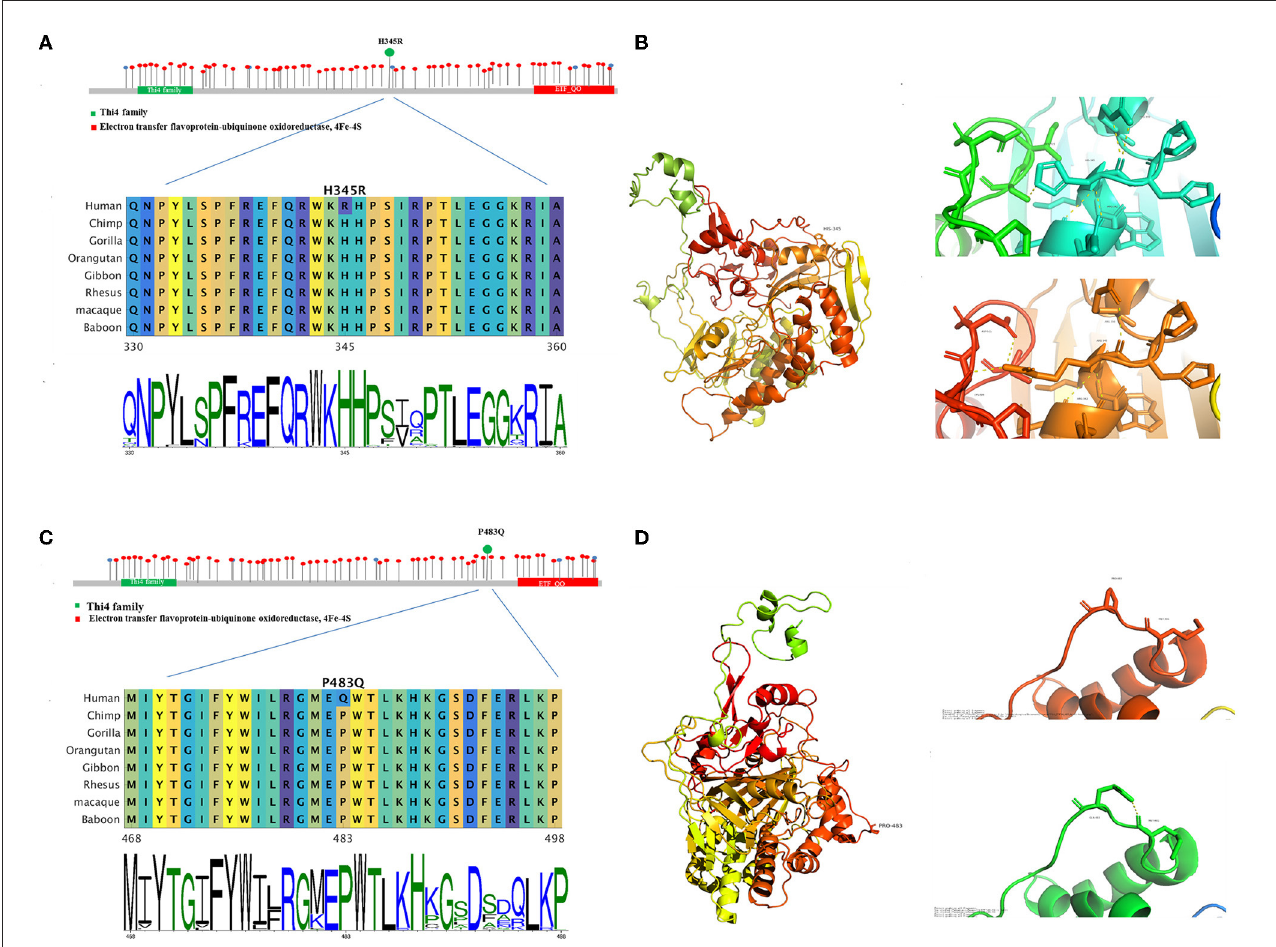
FIGURE4 The bioinformatic analysis of the two mutations observed in the proband. Allelic spectrum and location by the functional domain of reported pathogenic mutations of the ETFDH gene were shown. Multiplex sequence alignment of the ETFDH protein across eight different species shows that H345 and P483 are highly conserved among species (A, C) . The structure (B, D) was built by means of homology modeling based on 2 gmh with Identity 95. The structure is modeled by RosettaCM. The partial 3D structures of both mutations revealed polar interaction changes in the ETFDH